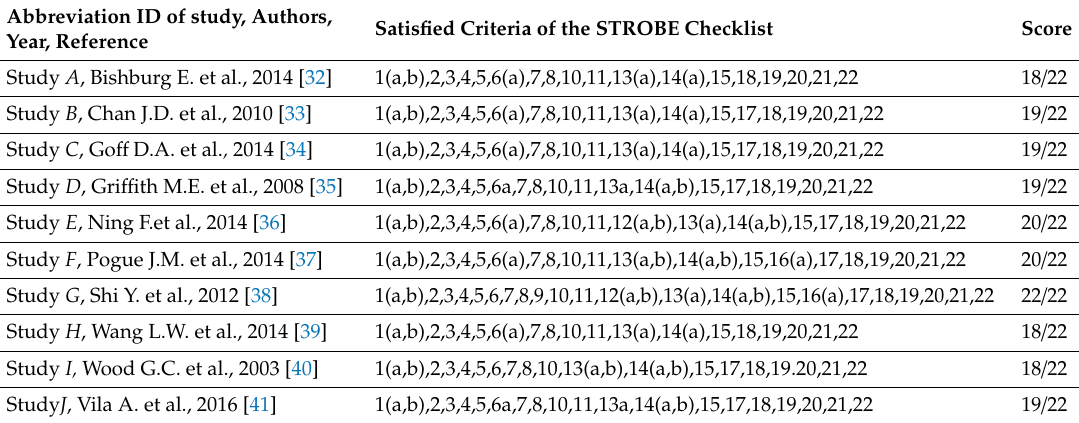
Table A1. The STROBE statement checklist scores for included